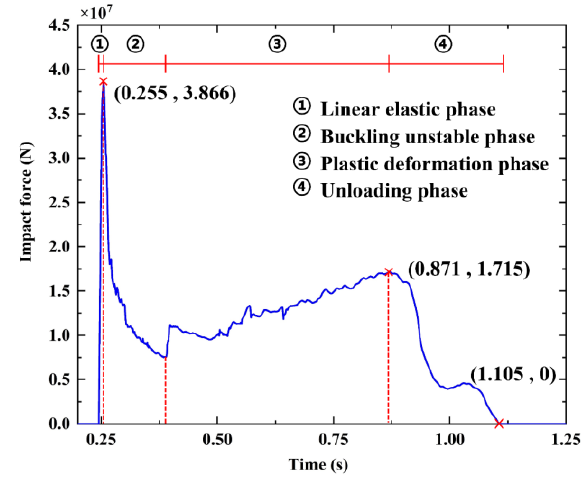
Figure 6. Four phases of impact force for collision.